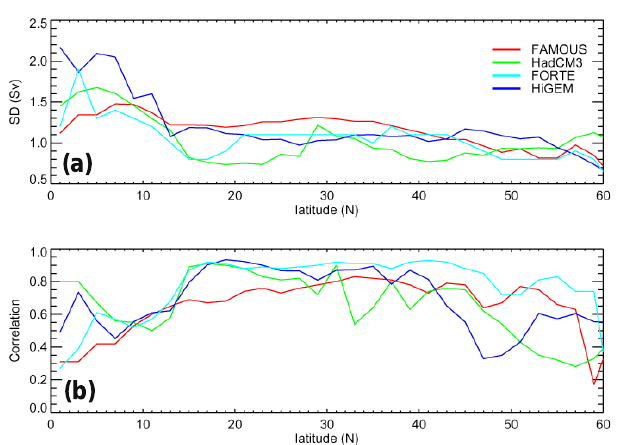
Fig. 8. Zonal profile of (a) annual ocean meridional overturning transport ( T over ) variability (Sv) and (b) correlation of annual T over and ocean meridional heat transport in the North